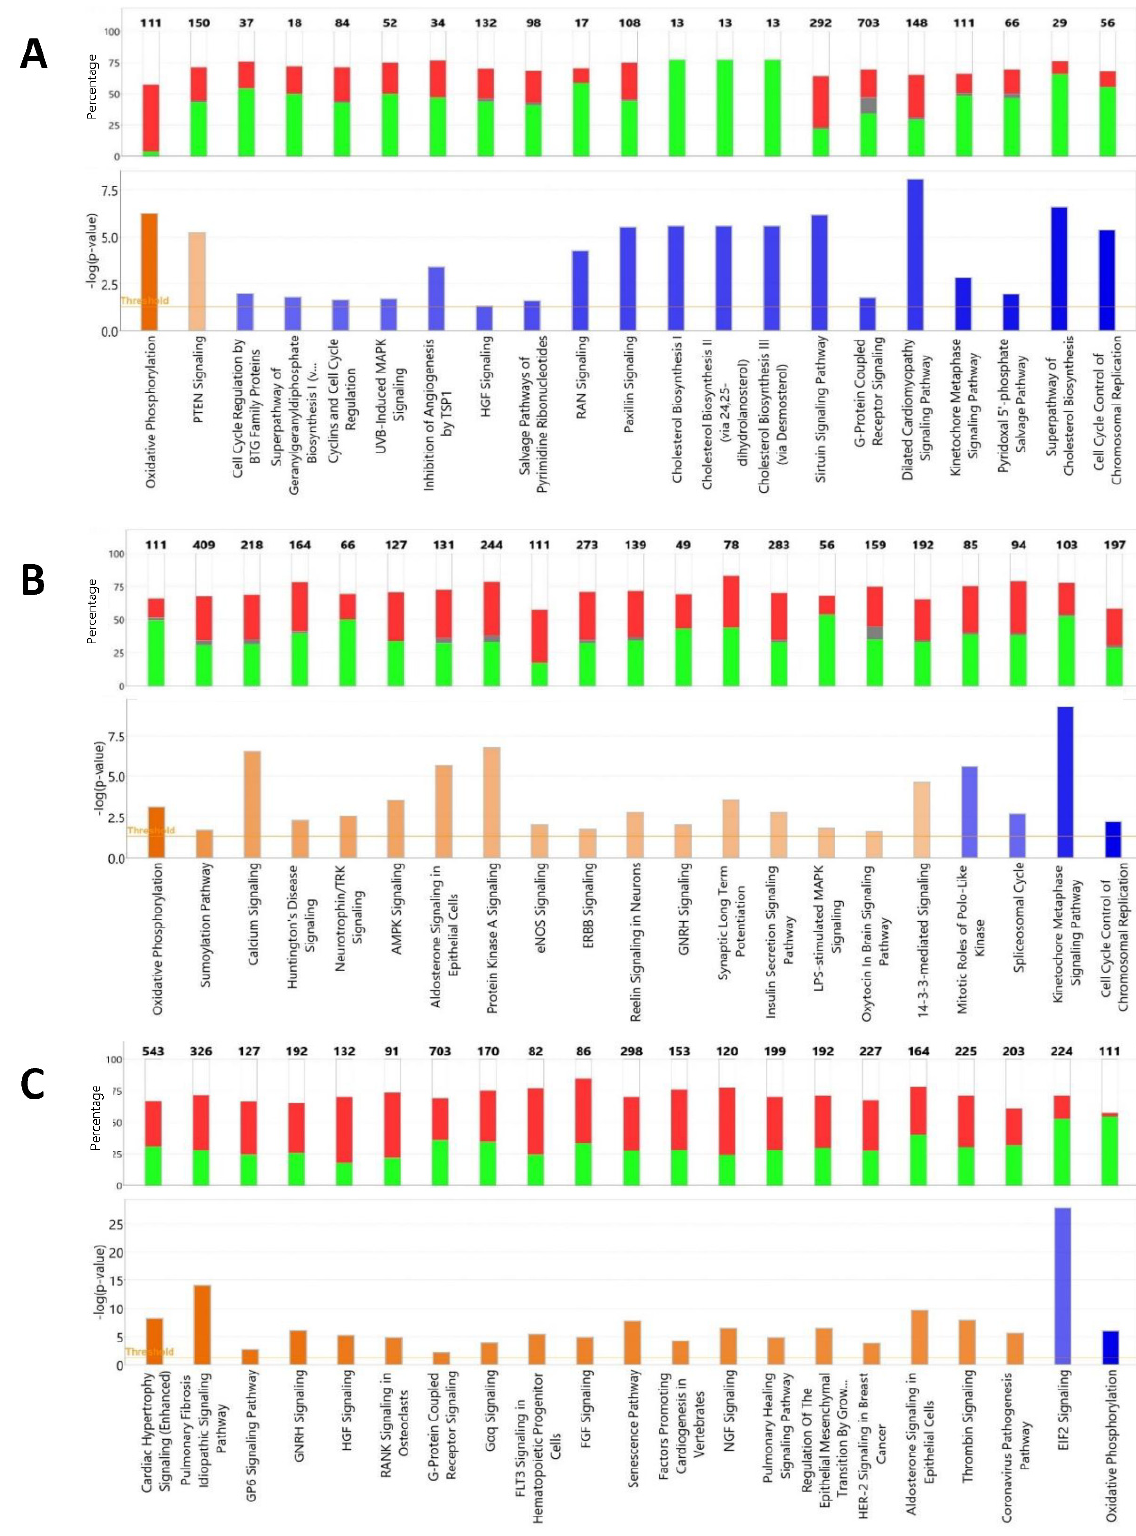
Figure 8. Summary of IPA Pathway Activity Analysis of DEGs observed comparison of NCT and RBC2 SCs differentiated at 38 ◦ C ( A ), 33 ◦ C ( B ) or 43 ◦ C ( C ). Pictured are the number of affected molecules, gene expression pattern and z-score for the significant canonical pathways with the greatest absolute z-score. Directional expression of genes is indicated by red (up) or green (down) and relative z-score by color intensity (orange = positive z and blue = negative z).